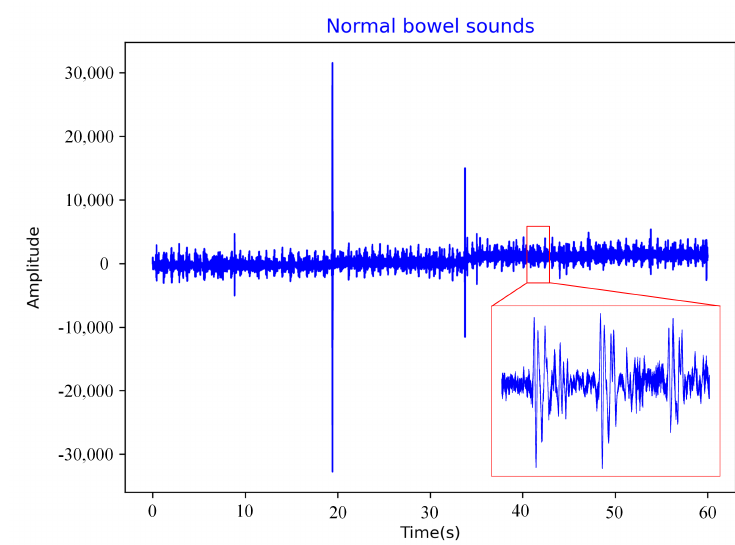
Figure 2. Physiological signal acquisition system.